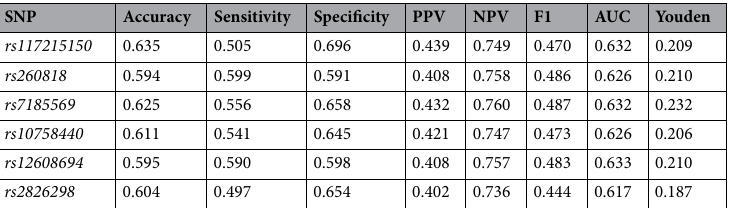
Table 2. Classification performance by candidate SNPs. Parameters of classification performance were calculated using the percentage of abnormal ECG in the cohort as the threshold. PPV/NPV positive/negative predictive value, AUC area under the ROC curve, Youden Youden index.